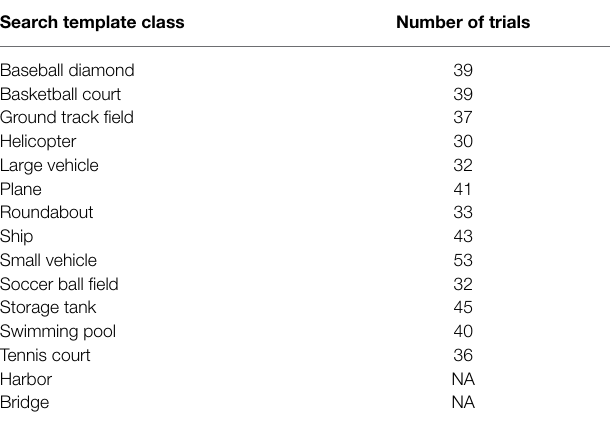
TABLE 1 | Number of trials for each search template class in Experiment